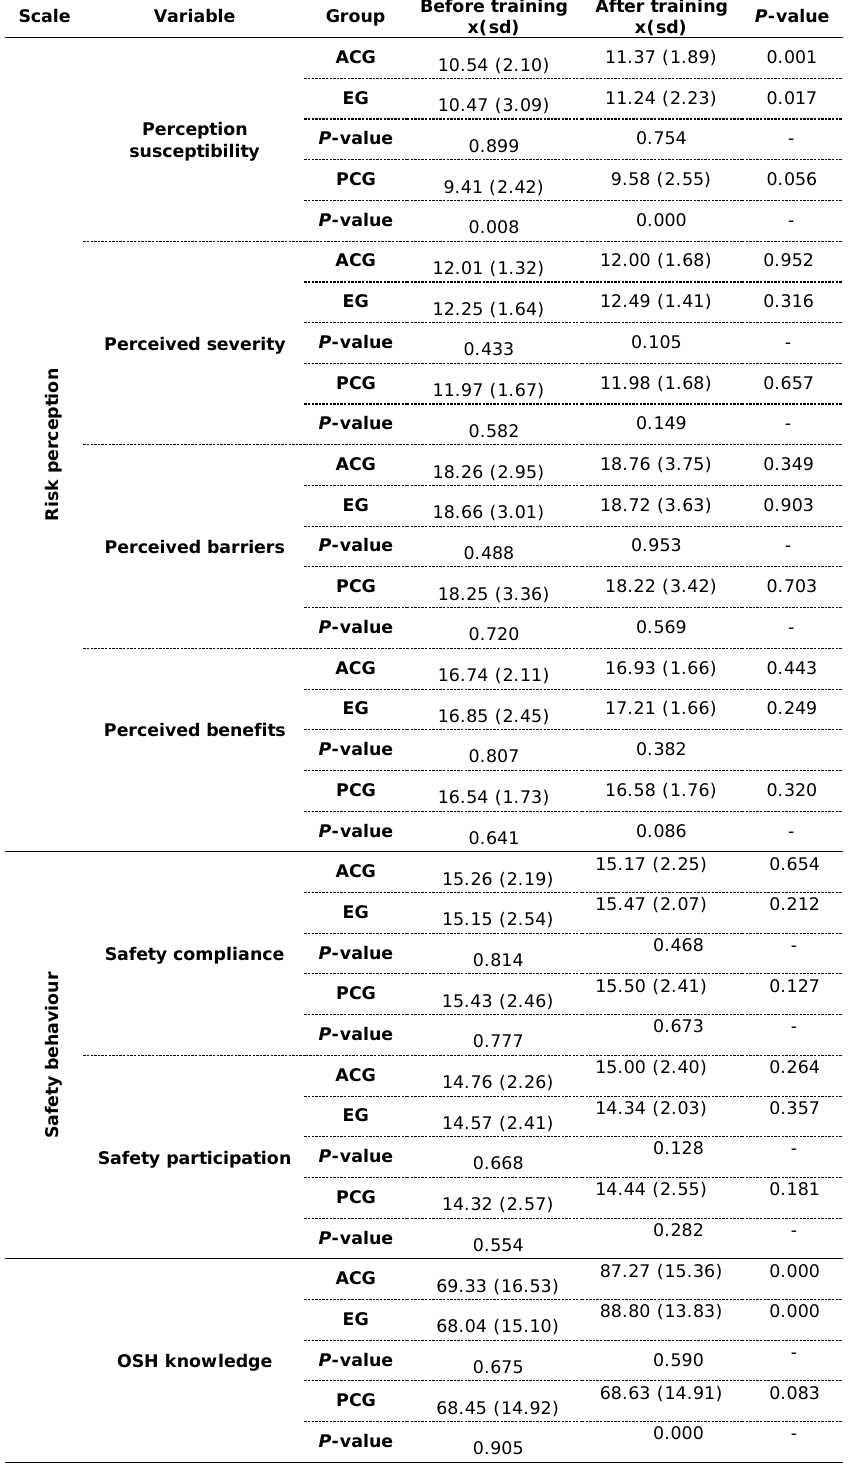
Table 2 - Comparison of the mean scores of the dimensions of risk perception, safety behaviour and OSH knowledge, a before and after the training